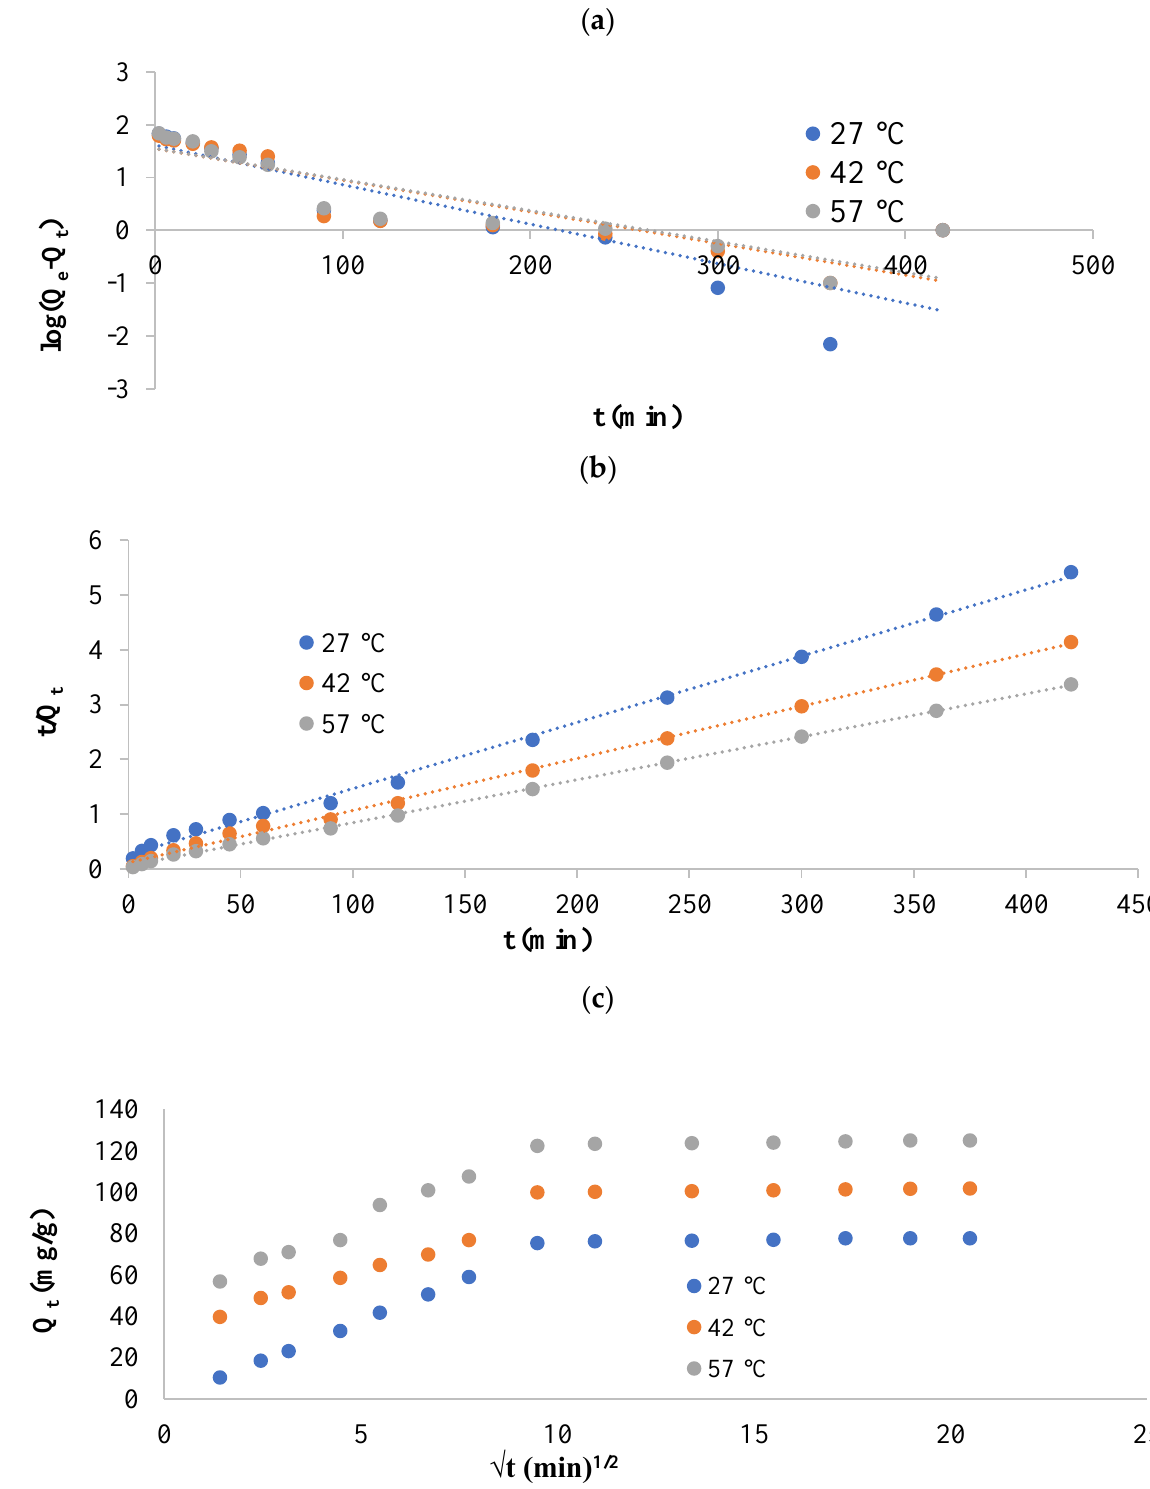
Figure 6. Kinetic plots of the first order ( a ), second order ( b ), and intra-particle diffusion ( c ) for CR adsorption by Zn/Cu-CR FVSP.